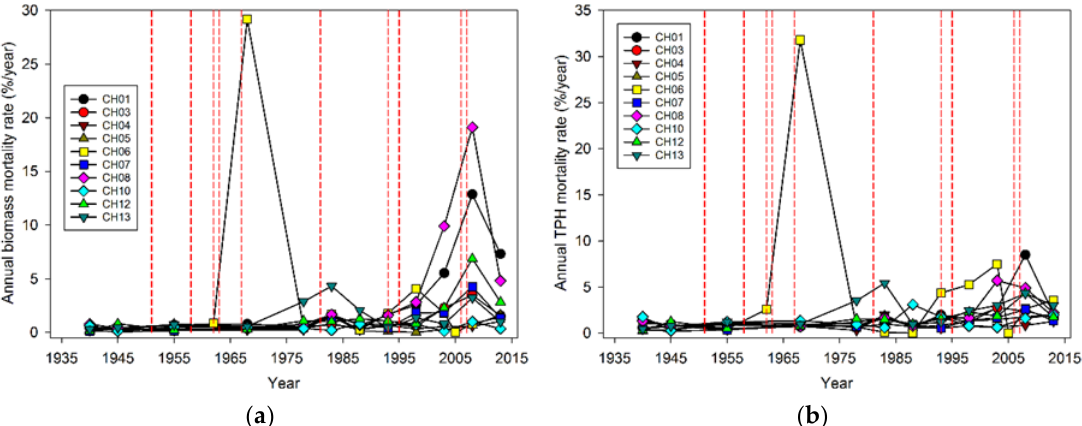
Figure 2. Annual rate of tree mortality (%/year) in each of the ten permanent plots based on ( a ) bole biomass, and ( b ) number of trees. The red vertical lines indicate major wind events.